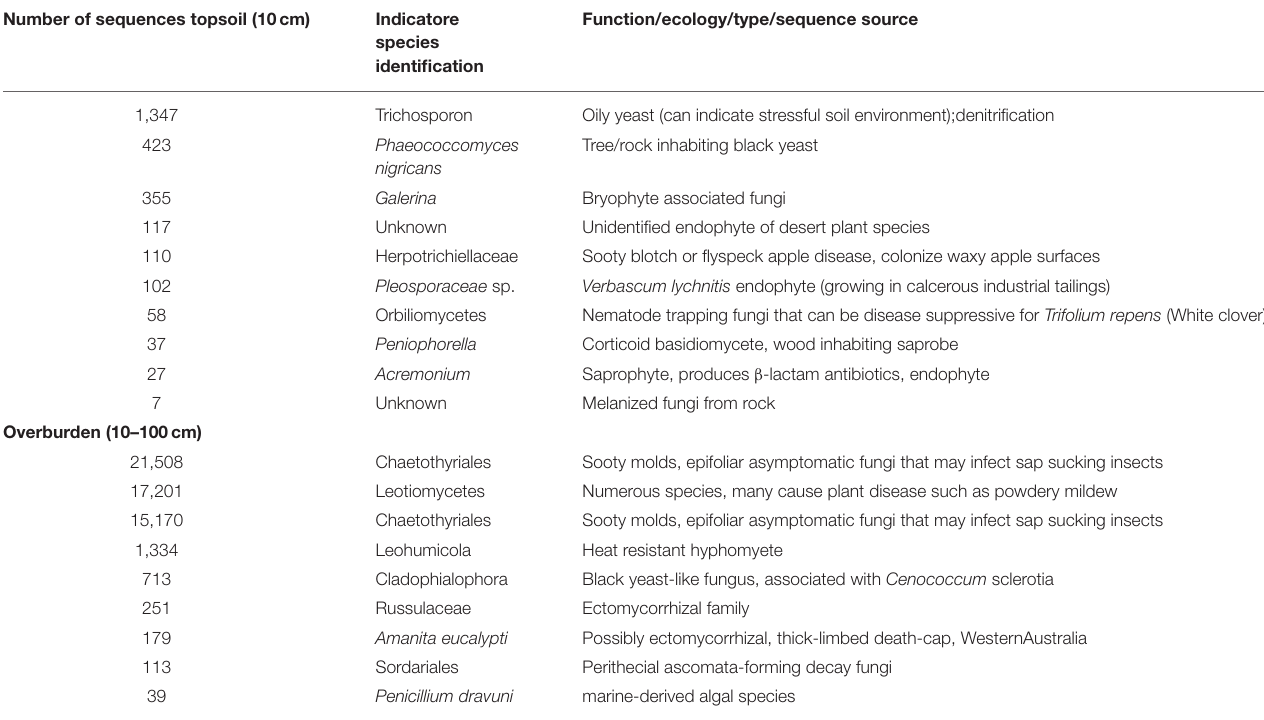
TABLE 1 | Inferred ecological function based on indicator species identity (species found in these samples to the exclusion of others) found in undisturbed reference overburden and topsoil. Number of sequences topsoil